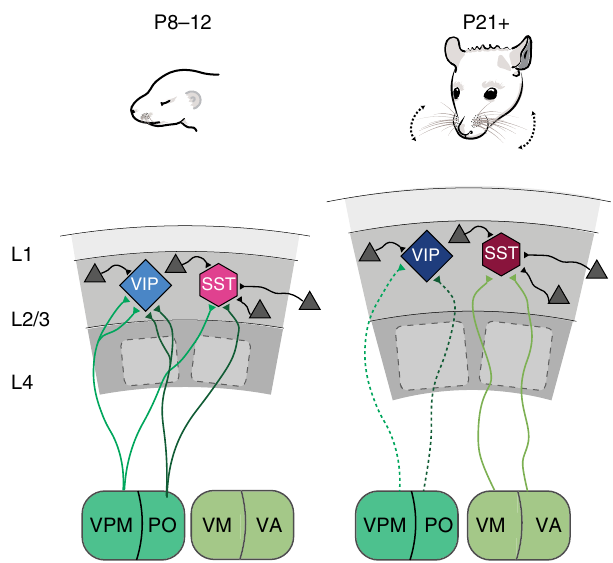
Fig. 5 Schematic of developmental input rearrangement onto super fi cial VIP + and SST + interneurons. Local connectivity: SST + INs receive excitatory inputs (gray triangles) from more distal source within the barrel cortex than VIP + cells both before and after P14. Bottom-up inputs: Before P14 both VIP + and SST + cells receive the majority of their thalamic inputs from the VPM and PO nuclei of the thalamus, with the VIP + cells showing more thalamic synapses on their dendrites. After P14 thalamic input onto VIP + cells is strongly reduced while the input onto SST + INs is shifted to the VM and VA thalamic